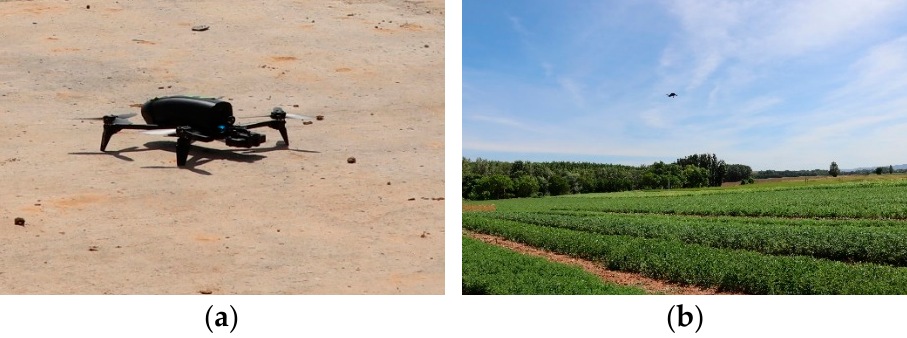
Figure 2. Image gathering process. ( a ) Drone used, ( b ) picture of image capturing process. The UAV was placed at 12 m and 16 m over the plots on 27 May 2021, when the plants were fully developed and starting to bloom, see Figure 2b). These heights were selected according to the positive results in [9] with images at 8 and 12 m. The selected heights and the small size of the drone ensured no draught caused by the drone’s propellers reached the leaves of the crops, which can complicate the image analysis. The plants have an approximate height of 30 to 40 cm. The day was selected to ensure good meteorological conditions and the plants’ phenological status. The camera’s exposure parameters were automatically selected, and images were acquired at 13:00 local time under clear and sunny conditions. The software of the camera automatically corrected the overexposure. For each height, at least five pictures were taken, to allow discard if any image was blurry. The three images with better quality were used. The pixel size was 0.63 cm 2 and 1.1 cm 2 for 12 m and 16 m,